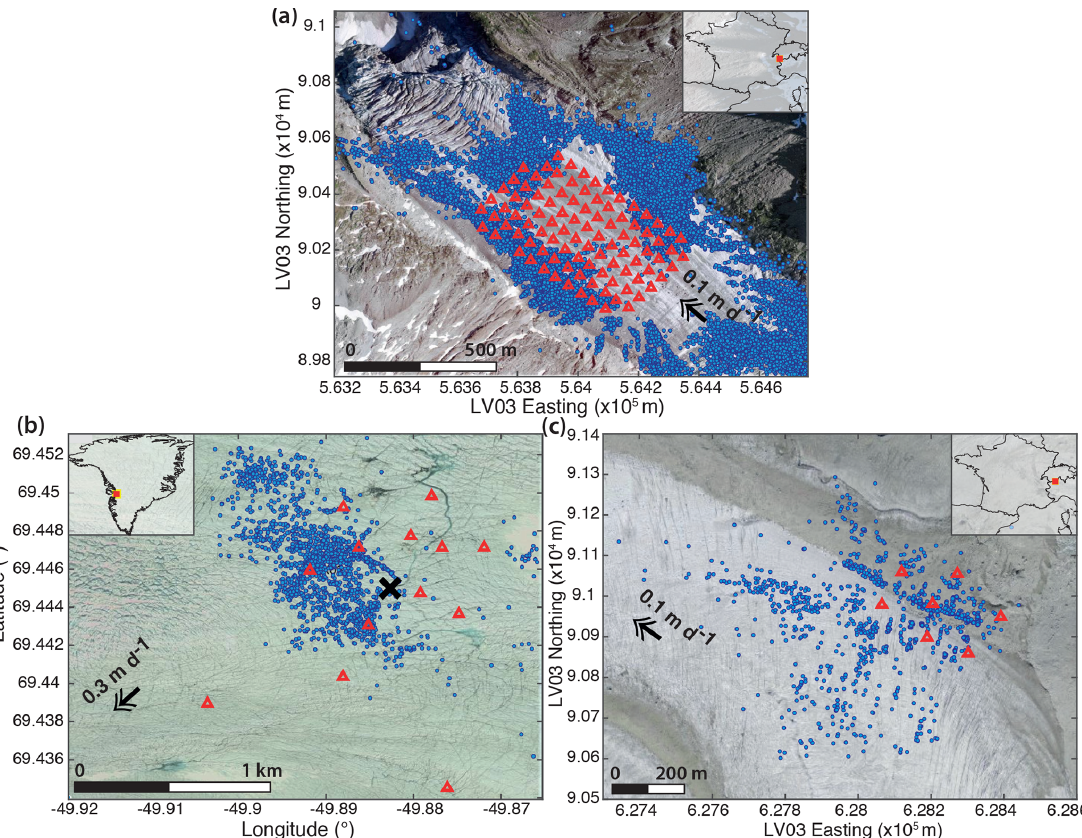
Figure 2. Icequake locations (blue dots) and seismic stations (red triangles) superimposed on aerial photographs of (a) Argentière (© IGN France), (b) the Greenland Ice Sheet (© Google, Mixar Technologies), and (c) Gornergletscher (© swisstopo, SWISSIMAGE). The black arrows indicate ice flow direction. Black cross in (b) indicates the location of the moulin within the